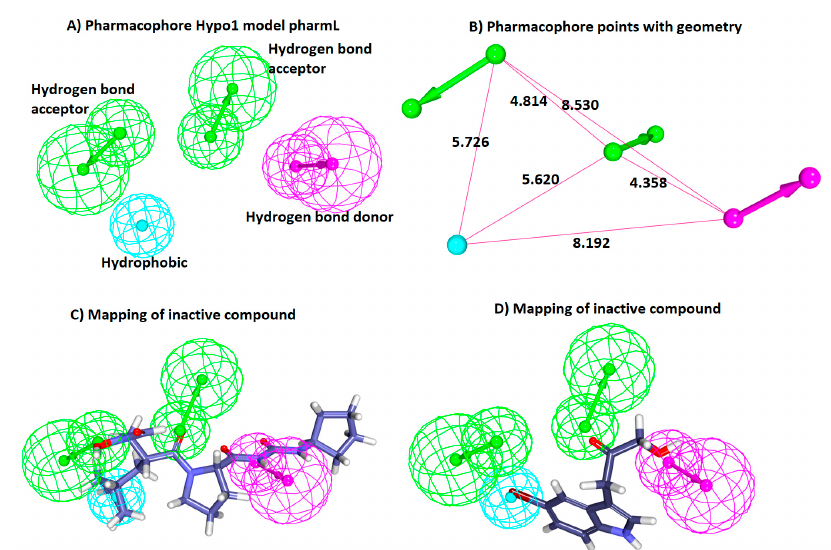
Figure 2. Characteristic four-featured HypoGen-guided pharmL. ( A ) PharmL consists of four features, including two hydrogen bond acceptor (HBA), one hydrogen bond donor (HBD), and one hydrophobic (HyP). ( B ) The geometry of the pharmL with its corresponding pharmacophore points. ( C ) Aligning of the most active compound to the model shows that it has mapped with all the features of pharmL. ( D ) Aligning of the inactive compound shows that it has mapped with three features of pharmL.